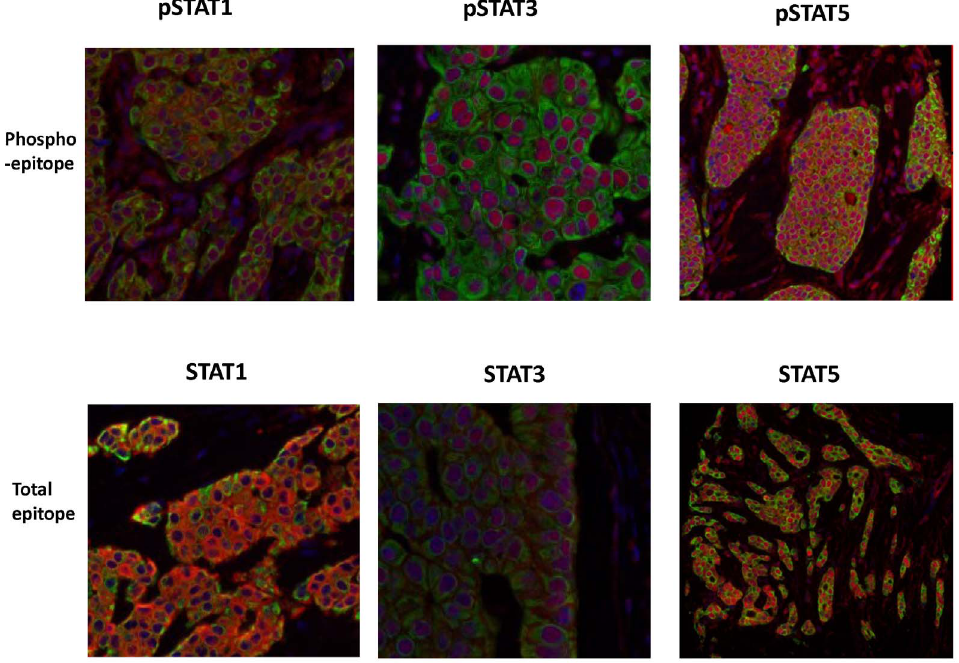
Figure 4. Comparison of STAT signaling in matched primary and metastatic tissue. Representative immunofluorescence images of phosphorylated and total STAT1, STAT3 and STAT5 in TMA cores. Blue = DAPI nuclear counterstain, green = cytokeratin tumor mask and red = target protein.